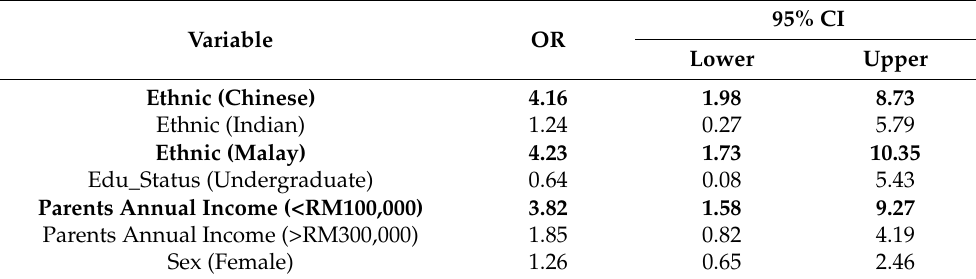
Table 2. Binary logistic regression analysis between sociodemographic factors and smoking status of the study participants (smoker vs.